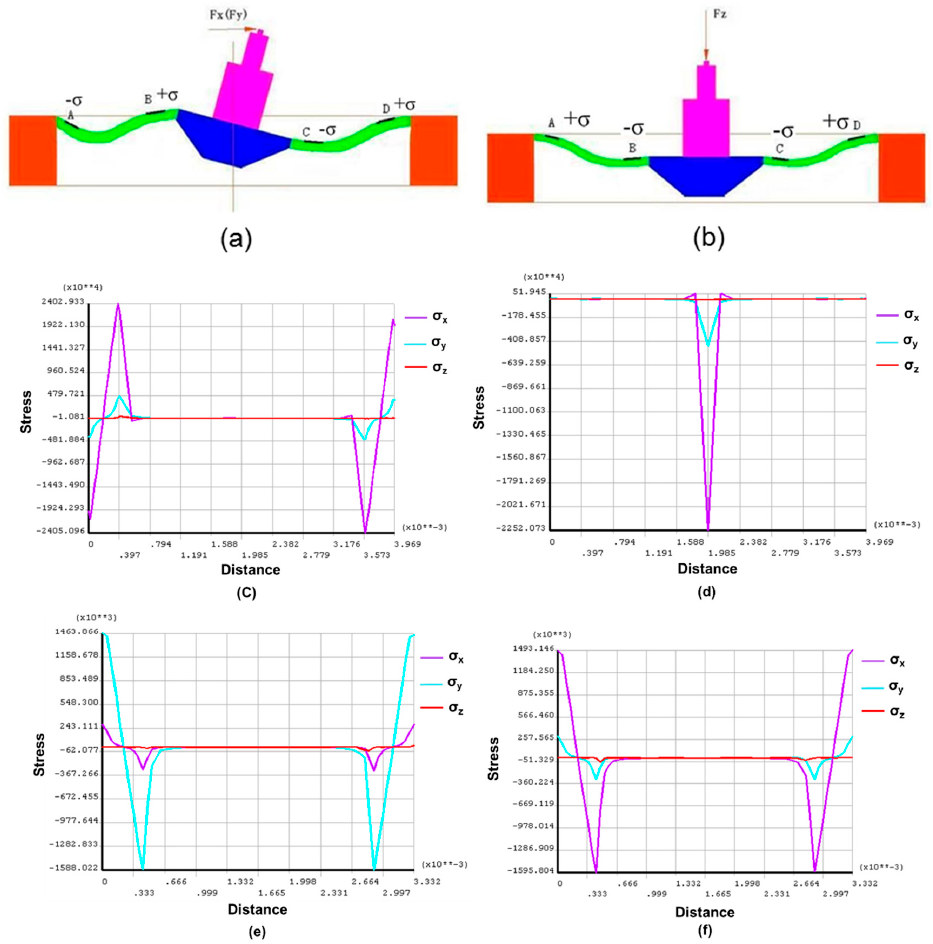
Figure 6. ( a ) Load F x ; ( b ) Load F z ; ( c ) Stress distribution on x beams with load of F x ; ( d ) Stress distribution on y beams with load of F x ; ( e ) Stress distribution on y beams with load of F z ; ( f ) Stress distribution on x beams with load of F z .